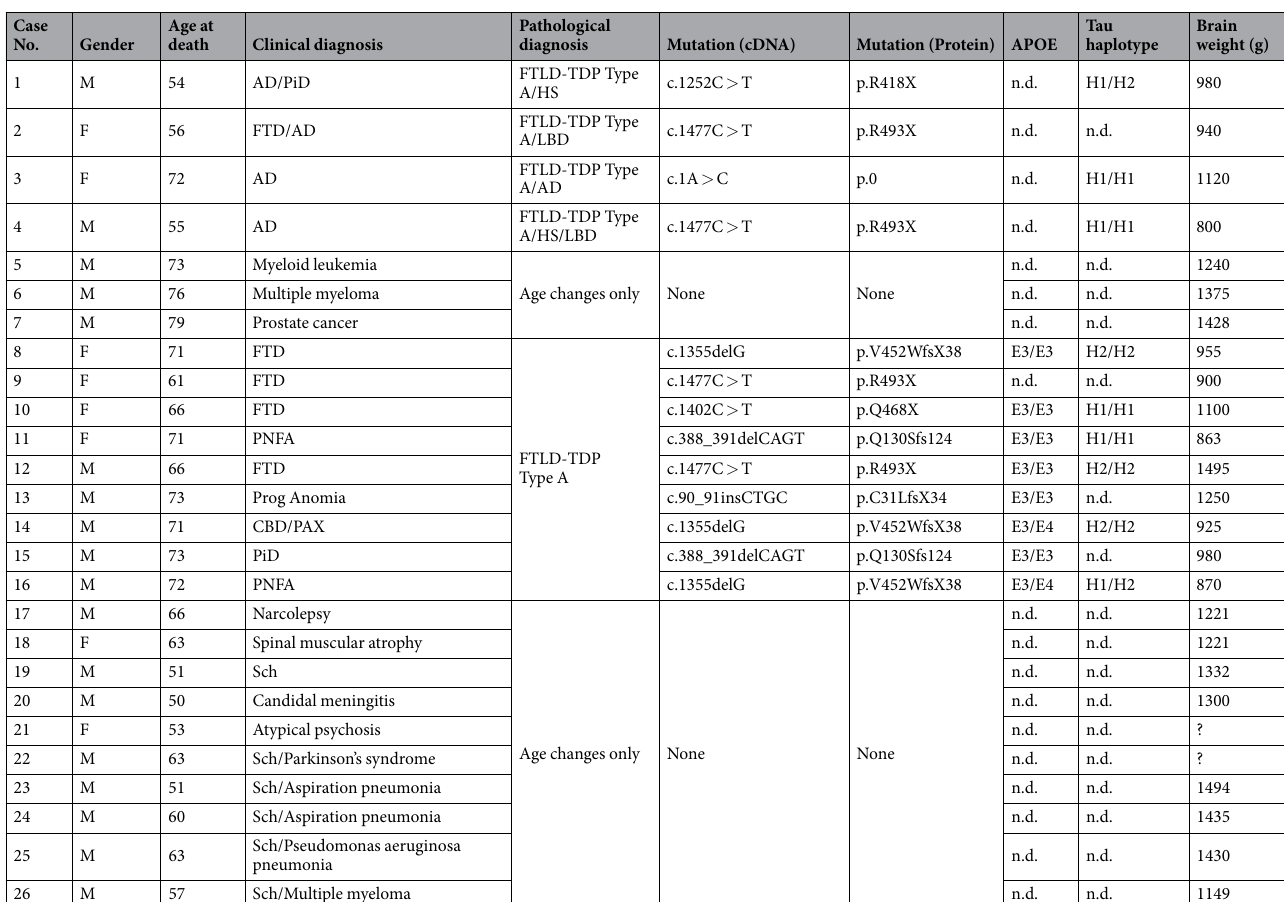
Table 1. Description of the GRN mutation and control cases used in the initial study (Study A, No. 1–7) and the additional cases used in the second study (Study B, No. 8–26). n.d.: not determined, Gender: F, female; M, Male. AD, Alzheimer’s disease; CBD, corticobasal degeneration; FTD, frontotemporal dementia; HS, hippocampal sclerosis; LBD, Lewy body disease; PAX, apraxia; PiD, Pick’s disease; PNFA, progressive non-fluent aphasia; Prog Anomia, progressive anomia; Sch,